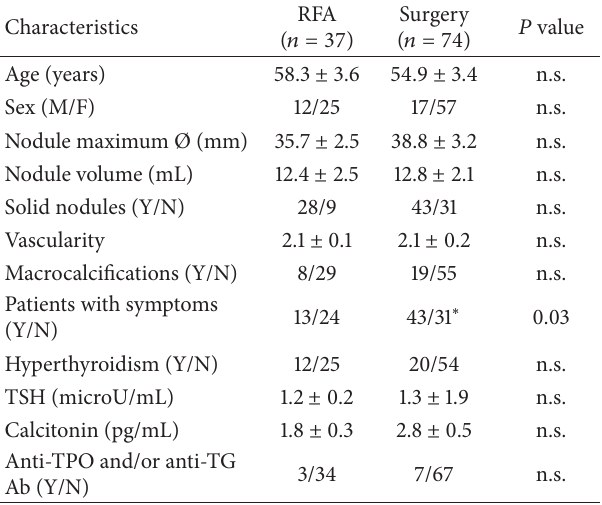
Table 1: Patients’ characteristics at baseline before either RFA or